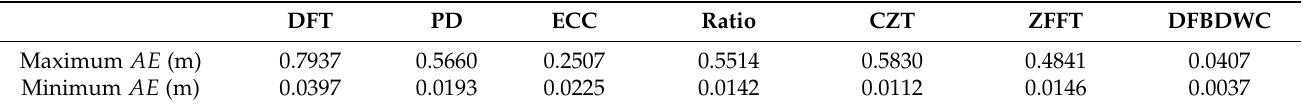
Table 6. Maximum and minimum AE of each algorithm.